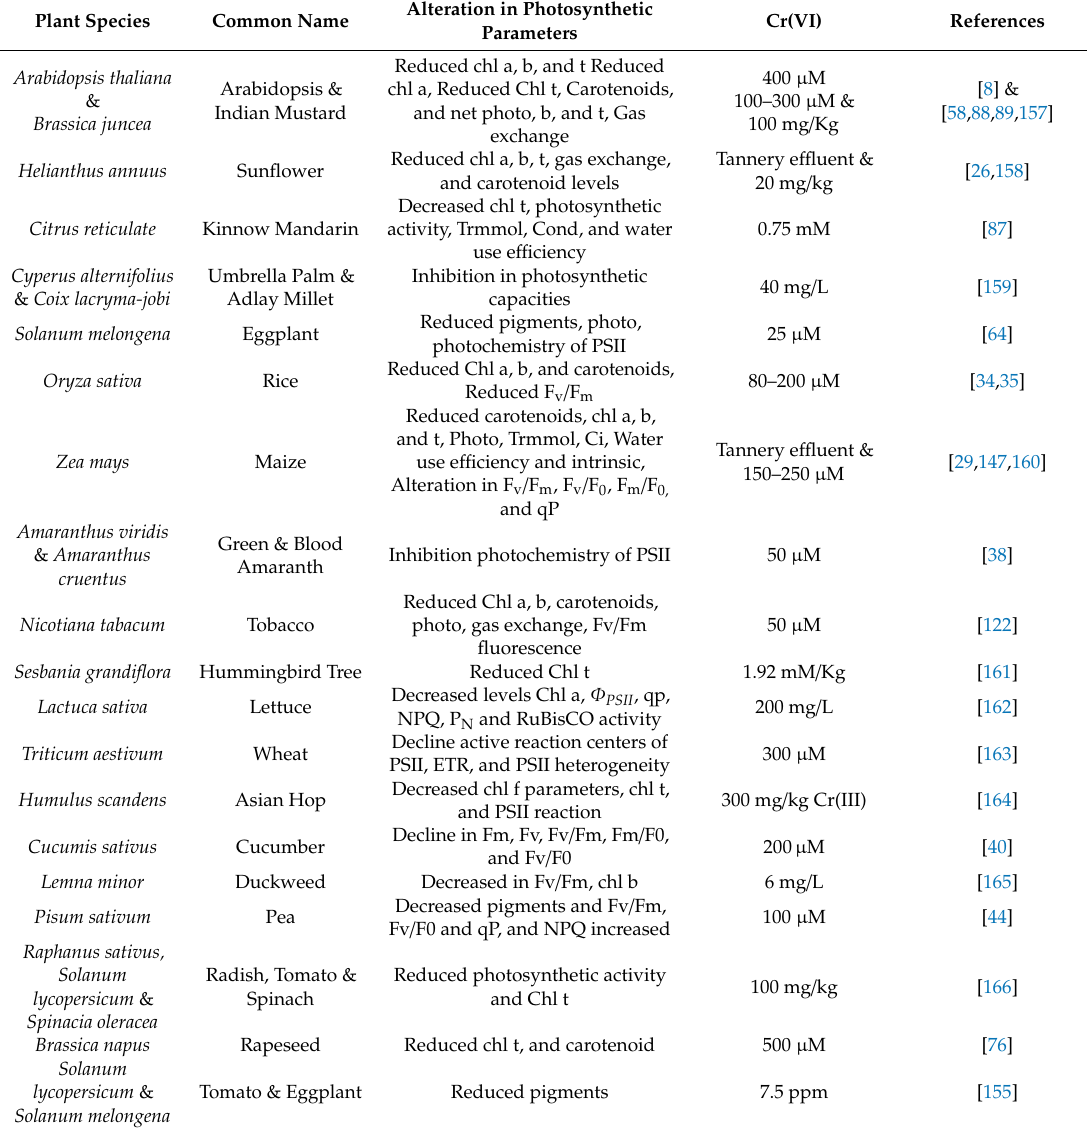
Table 6. Chromium-induced alteration in photosynthesis and photosynthetic apparatus in various plant species. Chl a (Chlorophyll a), Chl b (Chlorophyll b), Chl t (total chlorophyll), Chl f (chlorophyll fluorescence), Trmmol (transpiration rate), Cond (stomatal conductance), photo (photosynthetic rate), PSII (photosystem II), Ci (intercellular CO 2 ), Φ PSII (e ff ective quantum of yield of photosystem II), qP (photochemical quenching), NPQ (non-photochemical quenching), P N (net CO 2 assimilation rate), ETR (electron transportation rate), pigment (photosynthetic